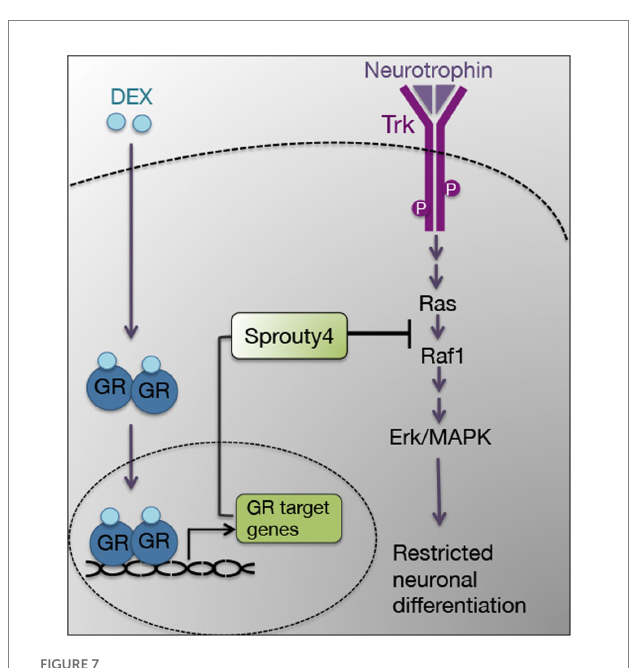
FIGURE 7 Model describing the proposed role of Sprouty4 as a signaling mediator of the inhibitory effect of DEX on neurotrophin-induced Erk1/2 pathway and neuronal